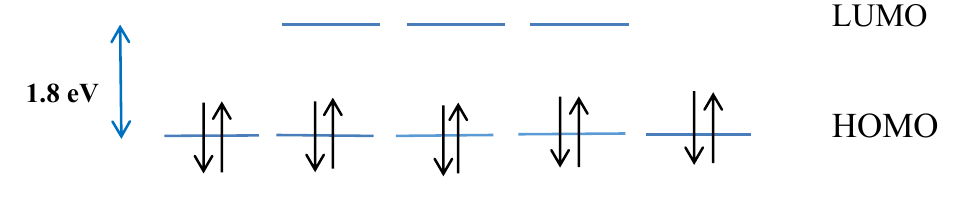
Figure 2. HOMO and LUMO gap in fullerene-C 60